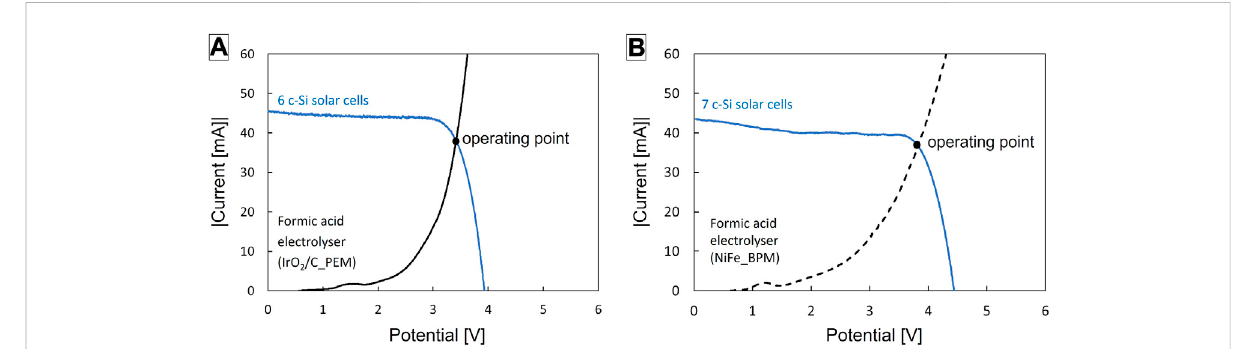
FIGURE 6 Matching of the polarisation curves of the electrolysers with that of a series of solar cells to optimize the coupling ef fi ciency and photocurrent, for the electrolyser with IrO 2 /C anode and PEM (A) and the electrolyser with NiFe anode and BPM (B) . The solar module was illuminated under 100 mW/cm 2 with a Xe lamp equipped with an infrared fi lter and air mass 1.5G fi lter. The solar cells had a surface area of 1.18 cm 2 each. The active geometric area of the electrodes was 4 cm 2 .